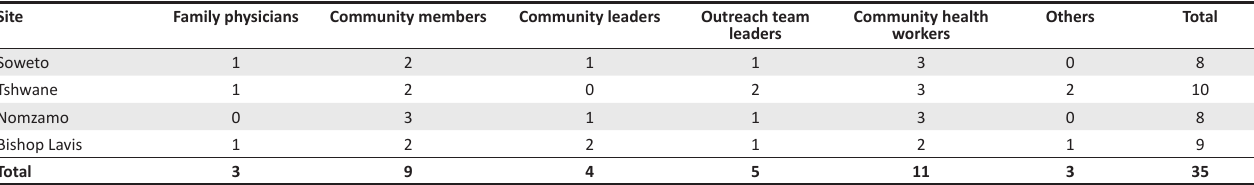
TABLE 1: Profile of key informants. Site